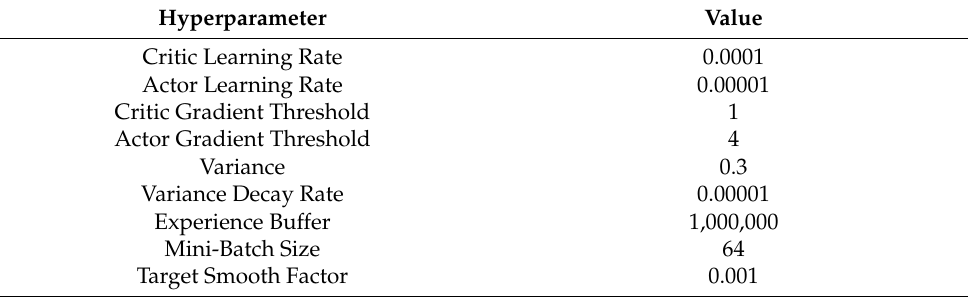
Figure 7. Episode reward and average reward recorded during training. To train the neural networks, different values for hyperparameters were applied, aimed at finding the best possible values. Table 4 shows the optimal values obtained for the hyperparameters. Table 4. The optimal values for